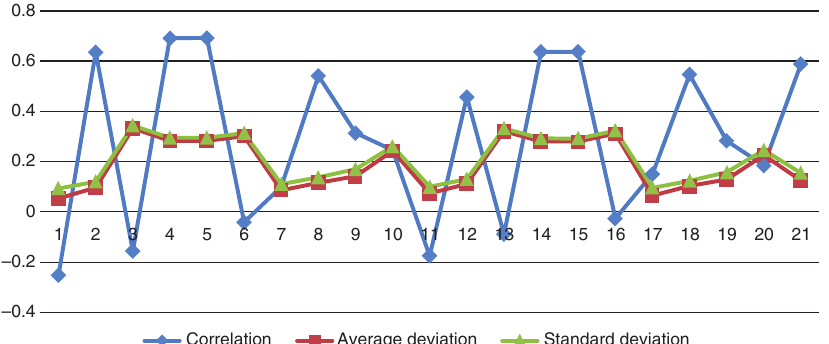
Figure 19: Overall Results for Kaggle Essay